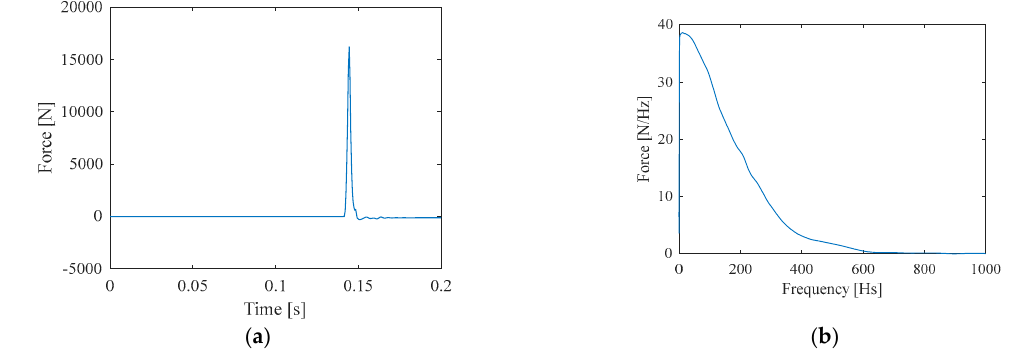
Figure 8. Example of the impact hammer force: ( a ) time history; ( b ) frequency